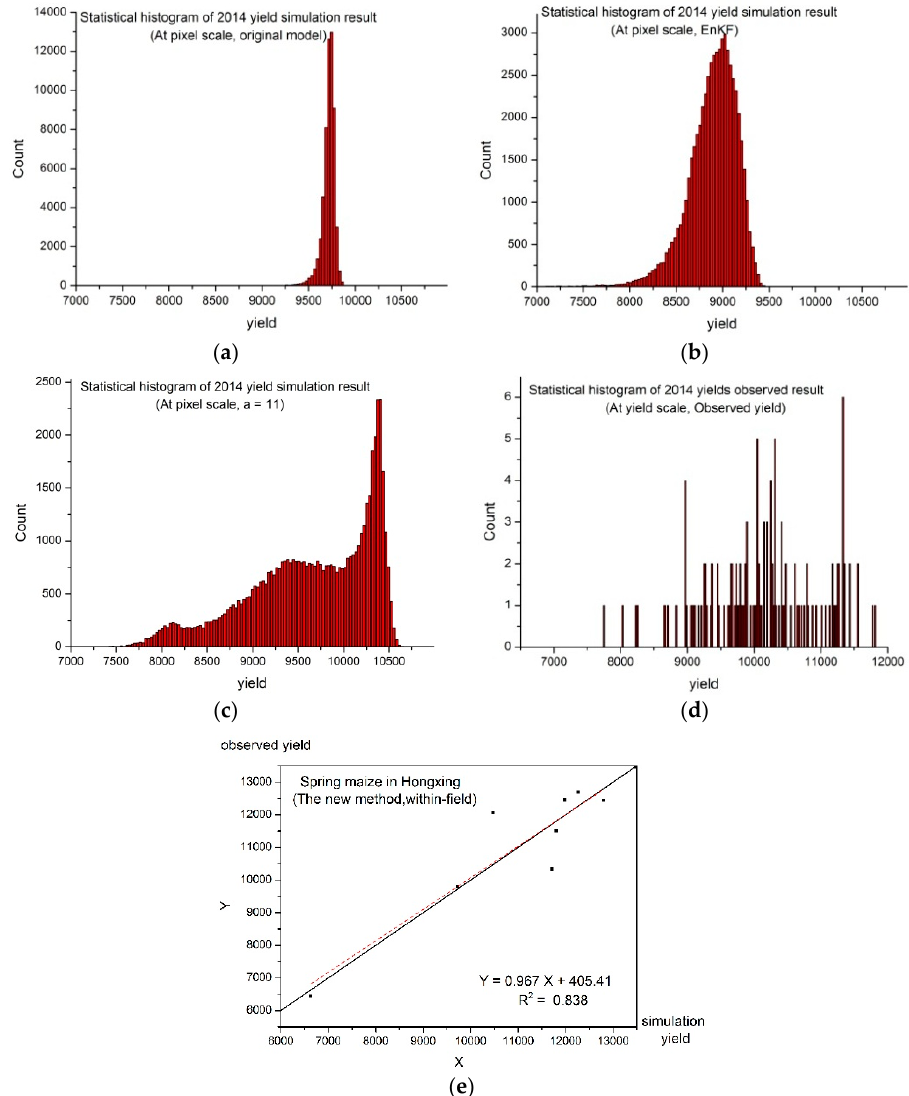
Figure 9. Statistical histograms and simulation accuracy within fields in 2014: ( a ) histogram of original, ( b ) histogram of EnKF, ( c ) histogram of new method ( a = 11), ( d ) histogram of observed yield, ( e ) simulation accuracy at within-field scale (new method). Table 13. Spatial heterogeneity of yield simulation results within fields (kg/ha).